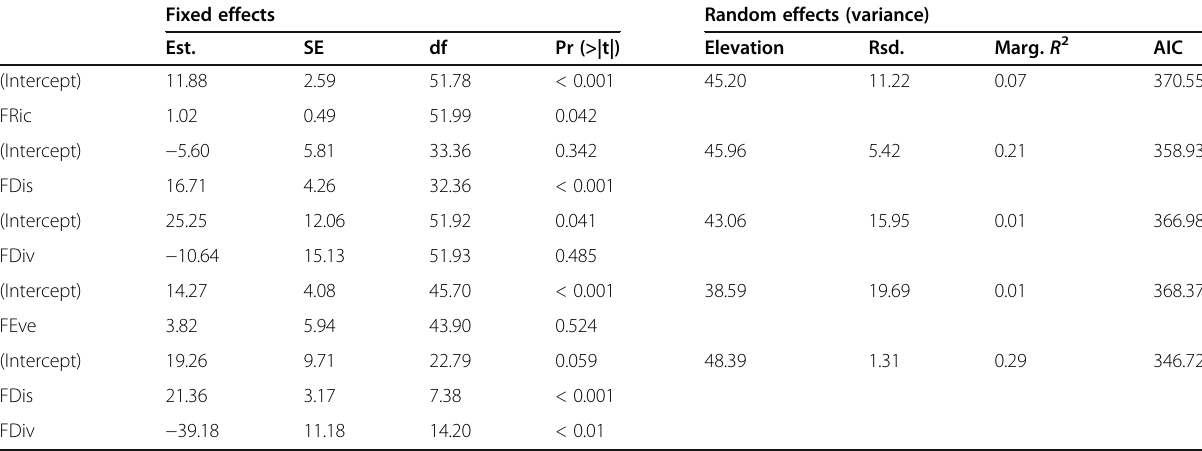
Table 3 The effect of functional diversity on AGC stock Fixed effects